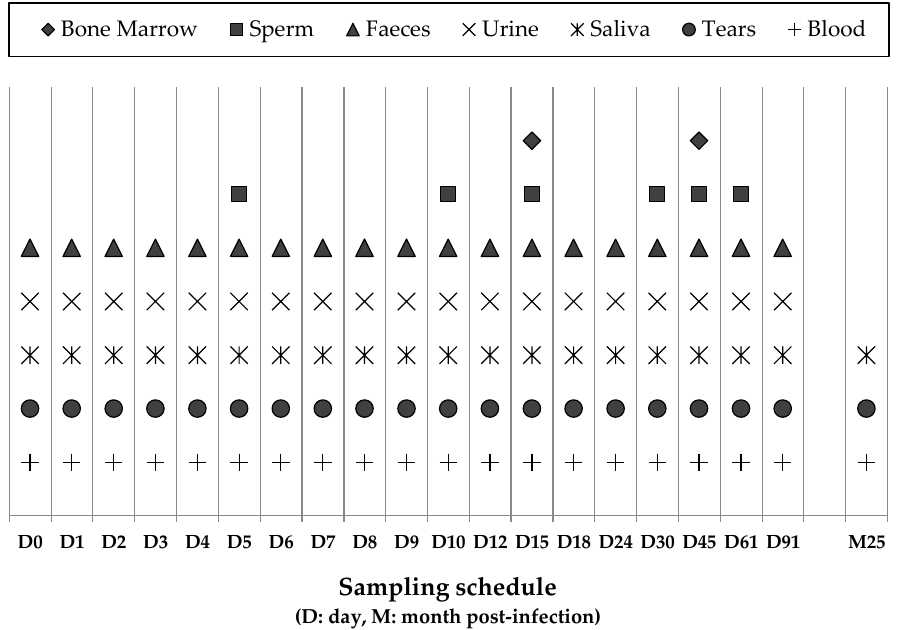
Figure 1. Collection of the specimens from dogs included in the study and the sampling schedule.